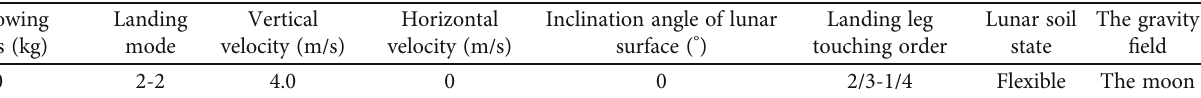
Table 7: Lunar lander soft-landing simulation